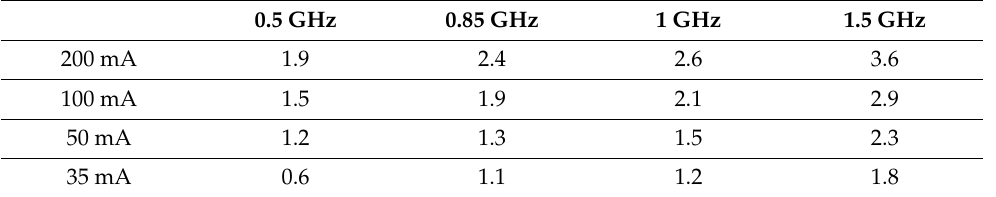
Table 1. Antenna system directivity (dB) for the first lamp configuration.